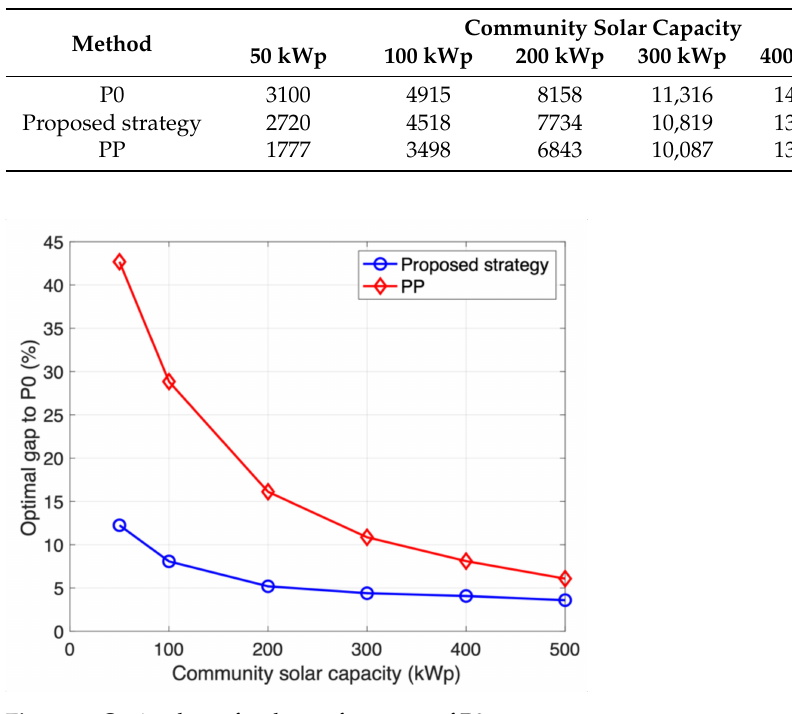
Figure 7. Optimal gap for the performance of